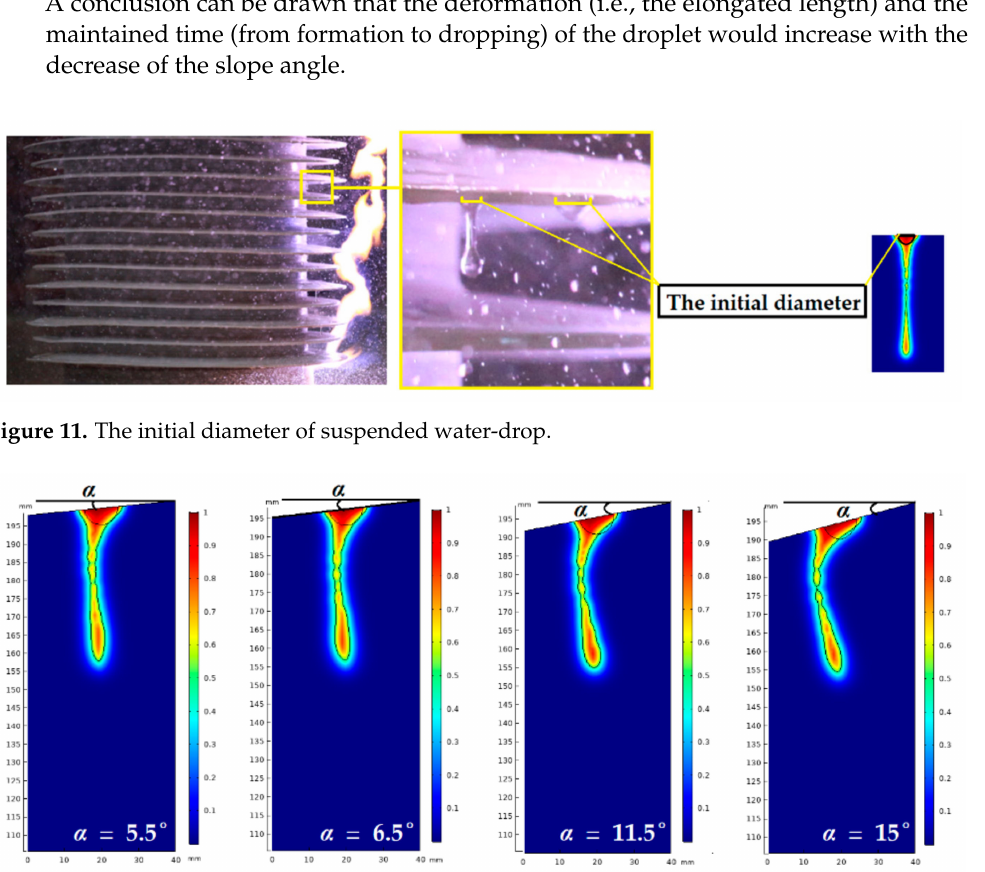
Figure 12. The shape of the suspended water-droplet under different values of slope angle. Briefly, Figure 13 shows typical parameters selected by the simulation model, which were consistent with parameters of the actual test specimen in this